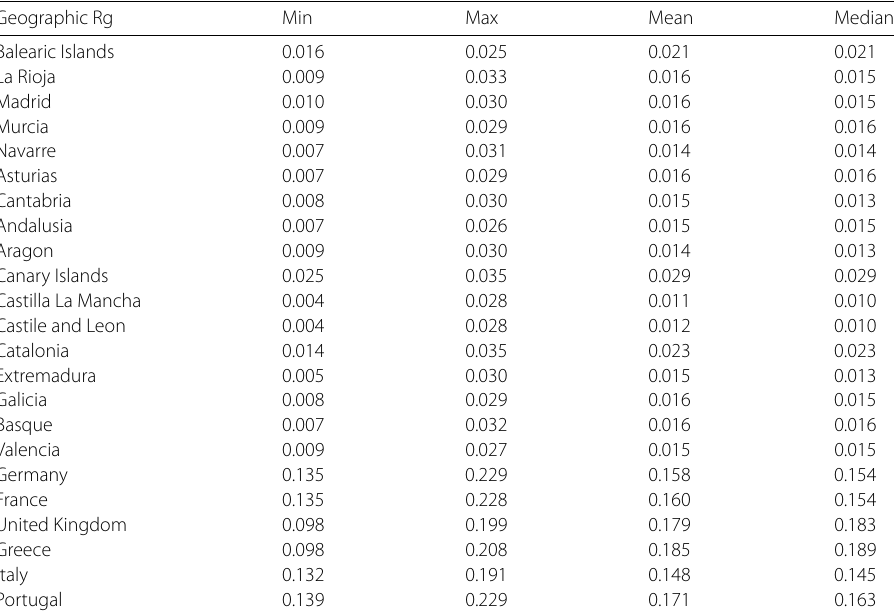
Table 2 Cosine distance between IPVs of geographic regions and Spanish CCAAs Geographic Rg